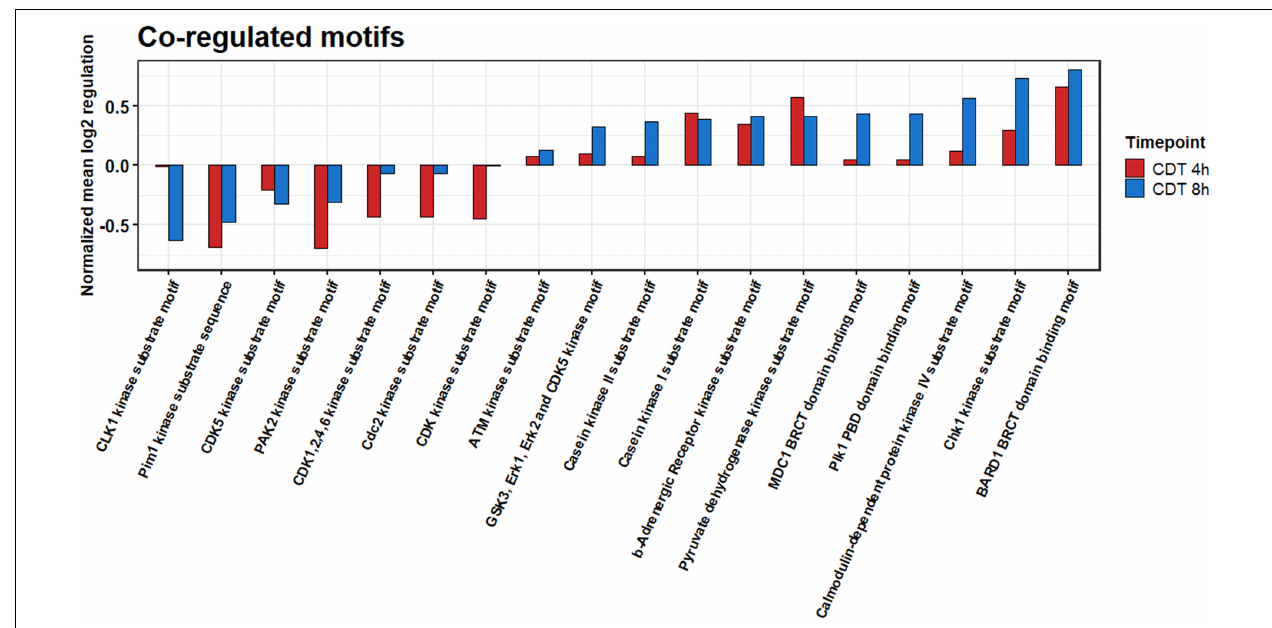
FIGURE 4 | Summed co-regulated phosphorylation of motifs of significantly changed phosphosites after 4 and 8 h of CDT treatment.